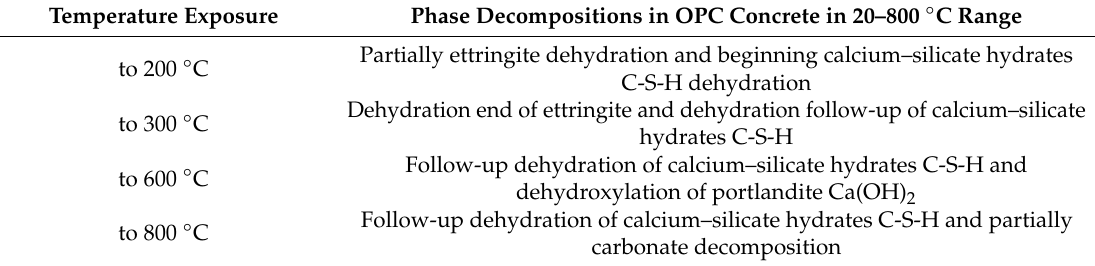
Table 1. Building Research Institute of Poland guidelines [27].